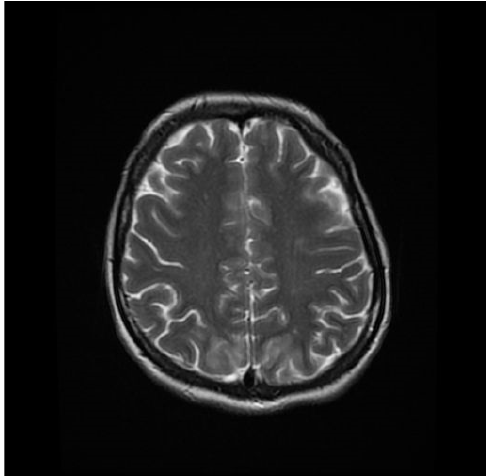
Figure 4. T2-WI MRI sequence of the brain in horizontal plane. Table 1. CSF